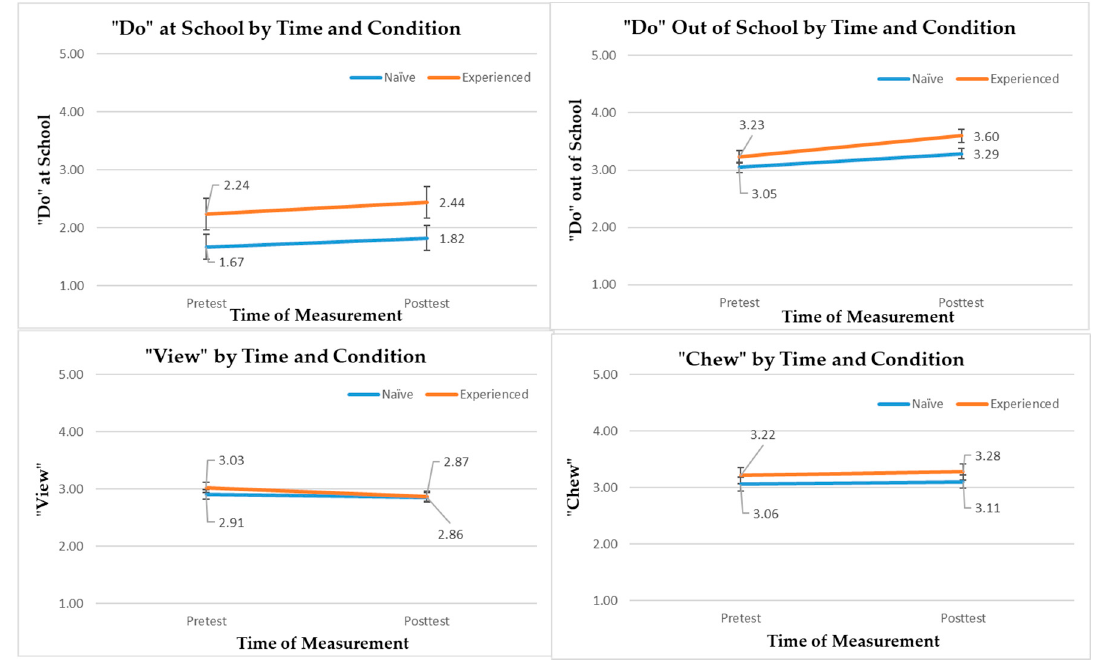
Figure 3. “Do”, “View” and “Chew” Behavioral Outcomes by Time and Group. Error bars denote standard errors. Note, lower values indicate lower level of screen-based sedentary behaviors for “View” behavior.